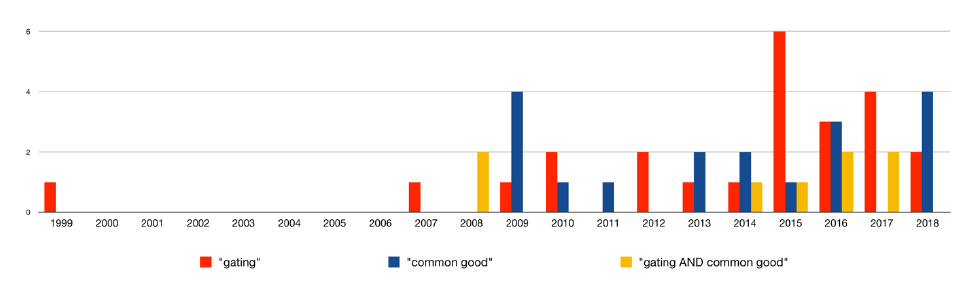
Figure 2: Timeline of articles in Gazeta Wyborcza Trójmiasto containing the